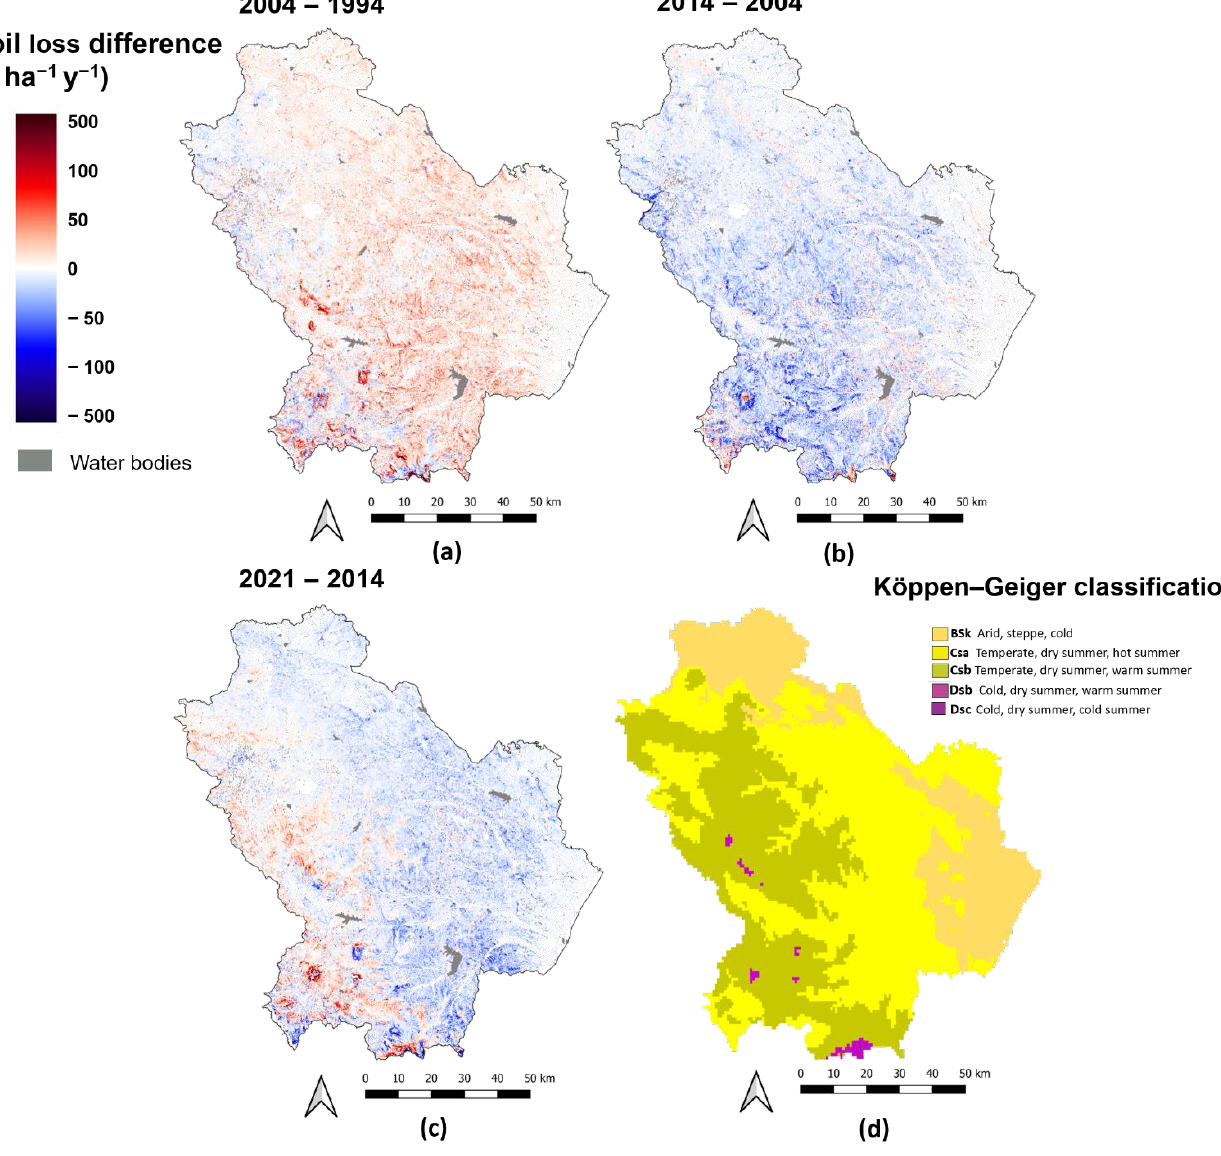
Figure 7. Difference of soil erosion rates for the time intervals: ( a ) 2004–1994; ( b ) 2014–2004; ( c ) 2021–2014; ( d ) Köppen–Geiger classification of climates.